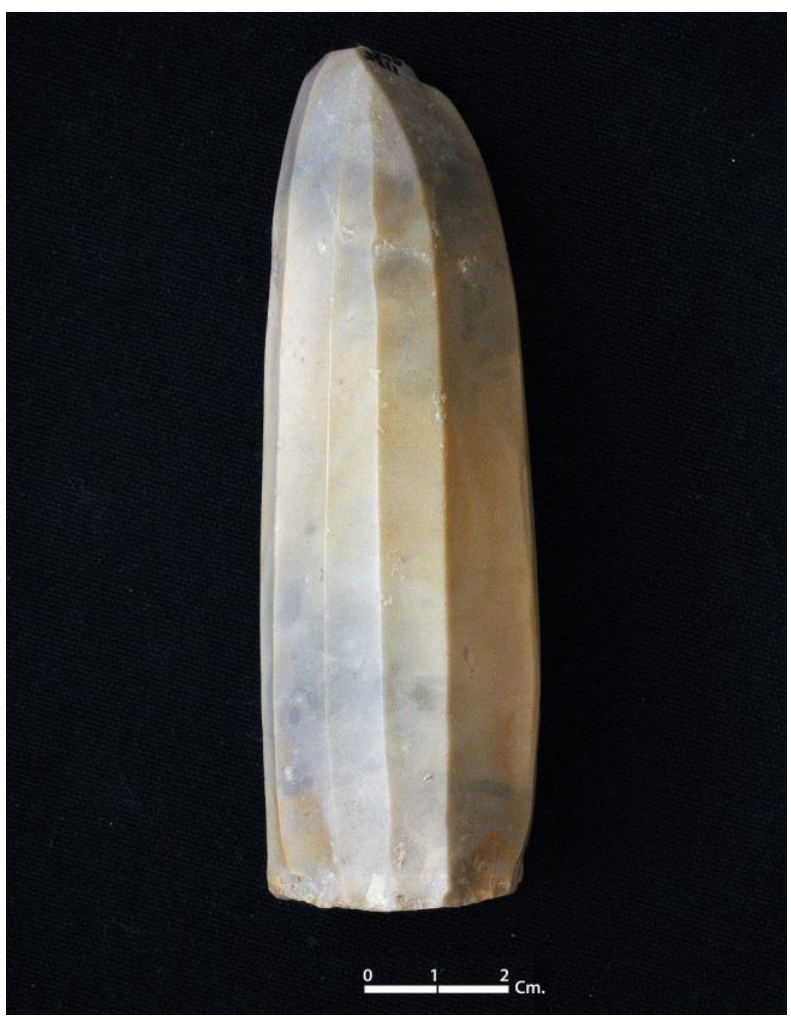
Figure 7. Conical Rohri chert blade core from